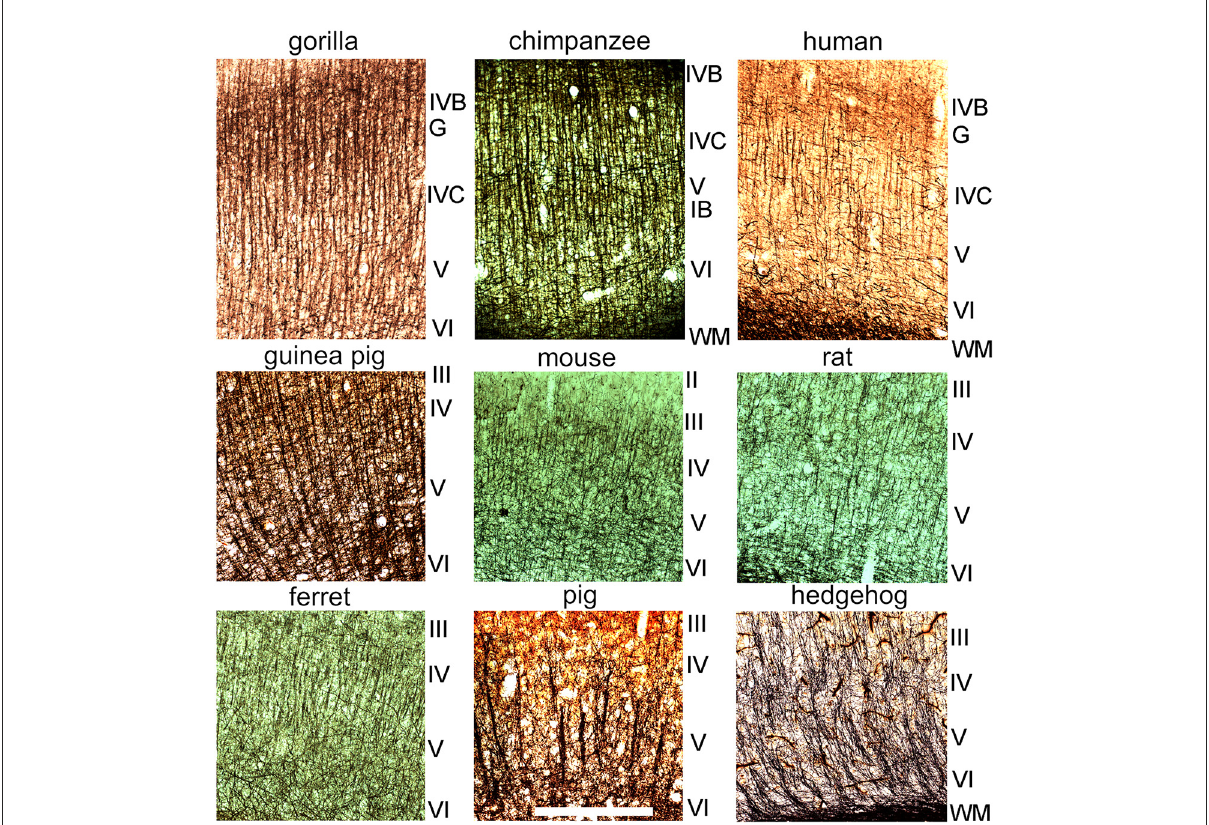
FIGURE2 Sections cut in a plane orthogonal to the cortical surface to show myelin staining in layers II–VI of the primary visual cortex in nine different mammalian species. The layers are indicated by the Roman numerals to the right of each panel. The sections are shown at the same magnification and the scale bar is 500 µ m. The stria of Gennari (G) of the three ape brains corresponds approximately to layer IVB while the inner band of Baillarger (IB) is seen most clearly in the chimpanzee brain and occurs within layer